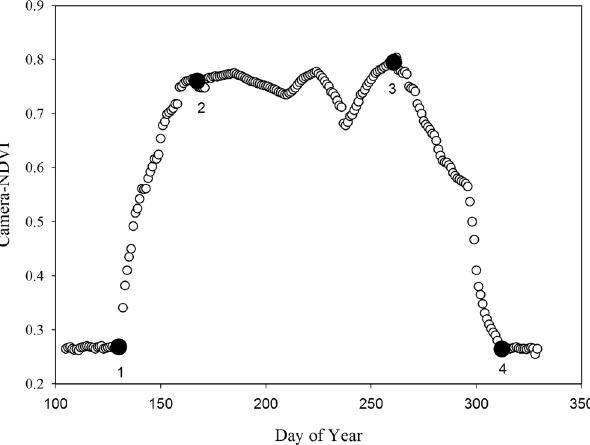
Figure 2. The seasonality parameters generated in TIMESAT from the smoothed time series of camera-NDVI: point 1 is beginning of season, point 4 is end of season, point 2 and 3 are the maximum values.